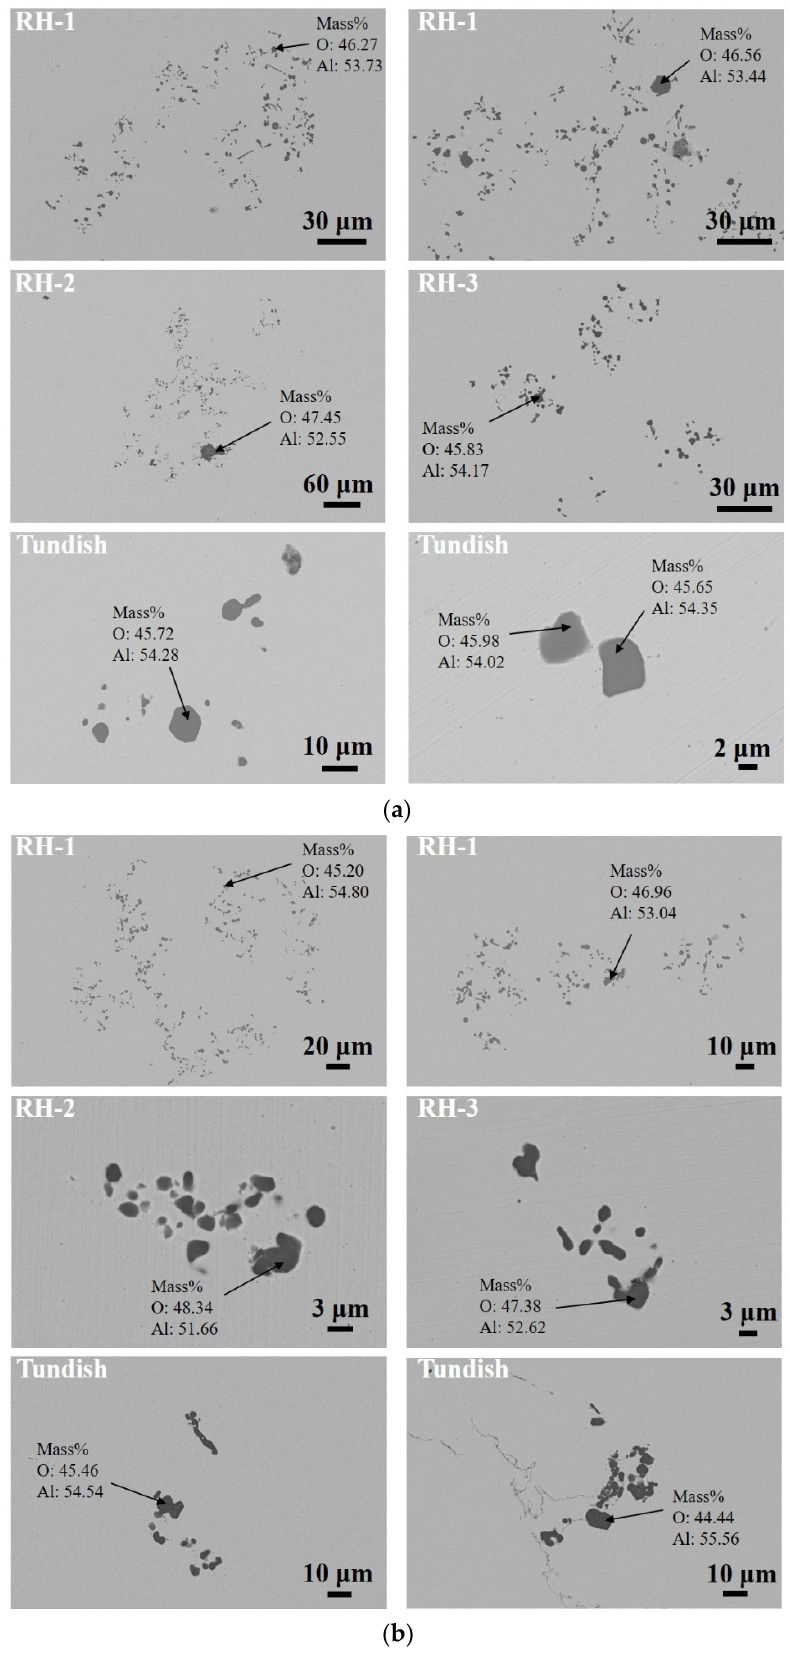
Figure 7. Morphologies of Al 2 O 3 inclusions during RH treatment and tundish processes. ( a ) Heat 1, ( b ) Heat 2.